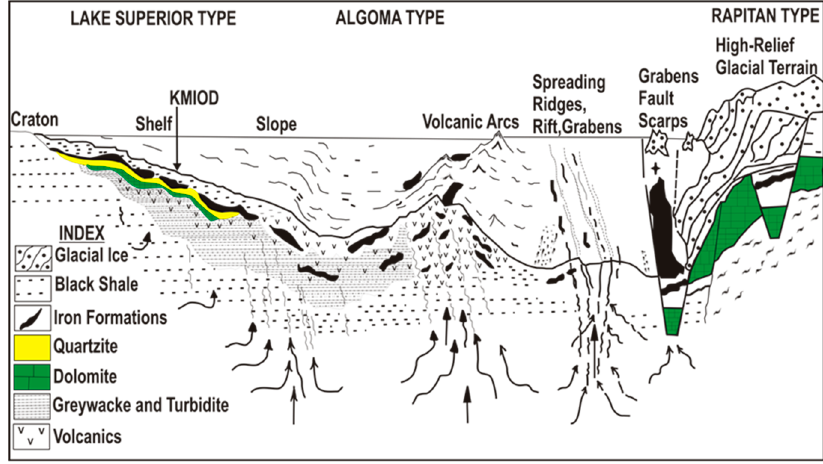
Figure 2. Distinguishing features of Lake Superior, Algoma and Rapitan types of iron formations, showing the possible position of the study area iron ore deposit (KMIOD) modified after [8,29].